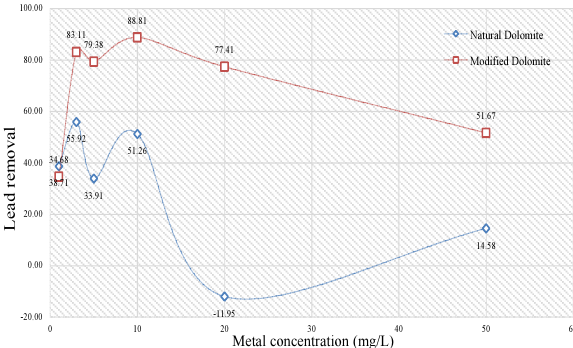
Fig. 13. Comparison of the removal of lead (%) from the solution in certain concentrations by 0.75 g of modified and natural dolomite within a 15 minute contact time